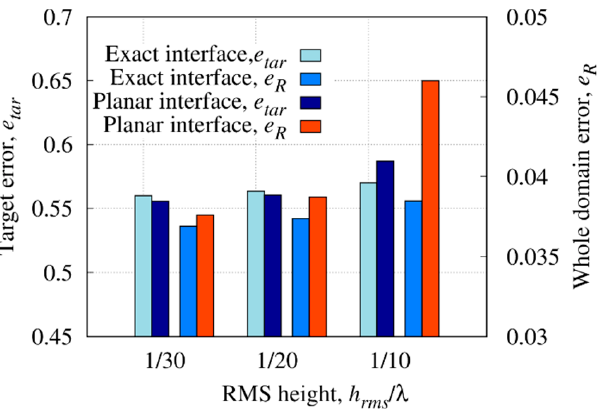
Figure 15. Reconstruction errors in the whole domain and inside the target versus the RMS height of the air–soil interface, h rms .